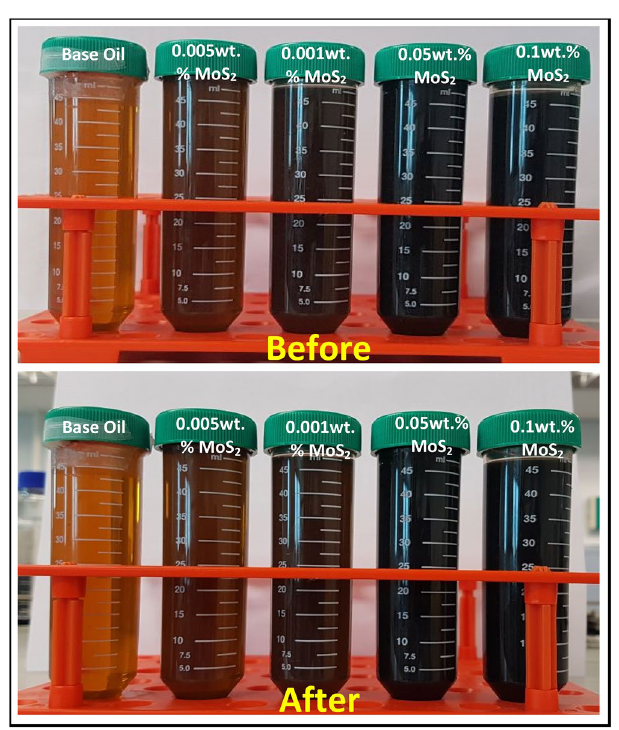
Figure 5. Visual observation of the dispersion stability of MoS 2 nanolubricants at varying